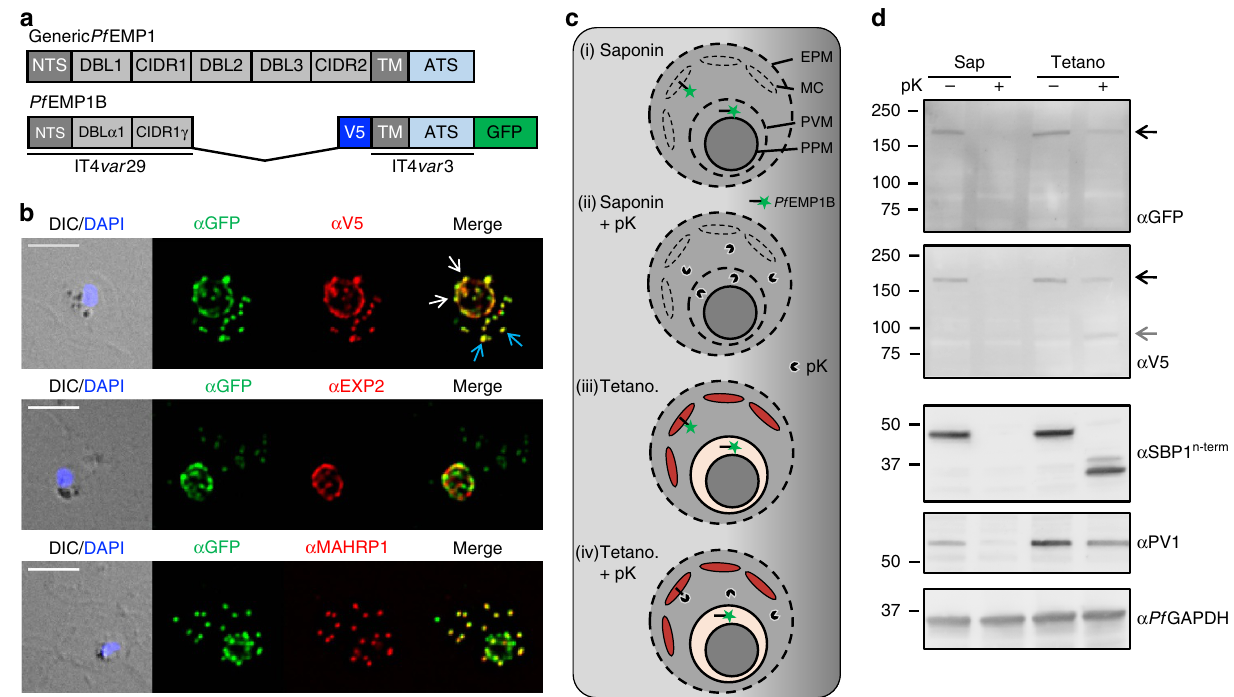
Figure 1 | Location and protease accessibility of Pf EMP1B during export. ( a ) Schematic of the minimal Pf EMP1 construct, Pf EMP1B, used in this study. Pf EMP1B contains the semiconserved head structure from IT4 var 29, an internal V5 epitope tag, a transmembrane (TM) domain and acidic terminal segment (ATS) from IT4 var 3 followed by GFP. Structure of a generic Pf EMP1 molecule is shown above. ( b ) Immunofluorescence analysis of Pf EMP1B- infected RBCs labelled with antisera recognizing GFP (green) and V5 or EXP2 or MAHRP1 (red). Differential interference contrast (DIC) image and parasite nuclei (stained with DAPI; blue) are shown on the left. White arrows indicate PV-localized Pf EMP1B while blue arrows indicate Pf EMP1B located at the Maurer’s clefts. Scale bars, 5 m m. ( c ) Schematic of the protease protection assay performed on Pf EMP1B-infected RBCs. Cells were first treated with either saponin, to permeabilize the RBC membrane, the Maurer’s clefts and PVM or with Tetanolysin (Tetano) to permeabilize only the RBC membrane, and then incubated in the presence or absence of proteinase K (pK). ( d ) Western blots of the protease-treated infected RBCs were probed with anti-GFP and anti-V5 antisera. SBP1, PV1 and Pf GAPDH western blots are shown as controls. Full-length Pf EMP1B is indicated with a black arrow and the truncated product with a grey arrow. Molecular masses are shown in kDa. Uncropped western blots are shown in Supplementary Fig.